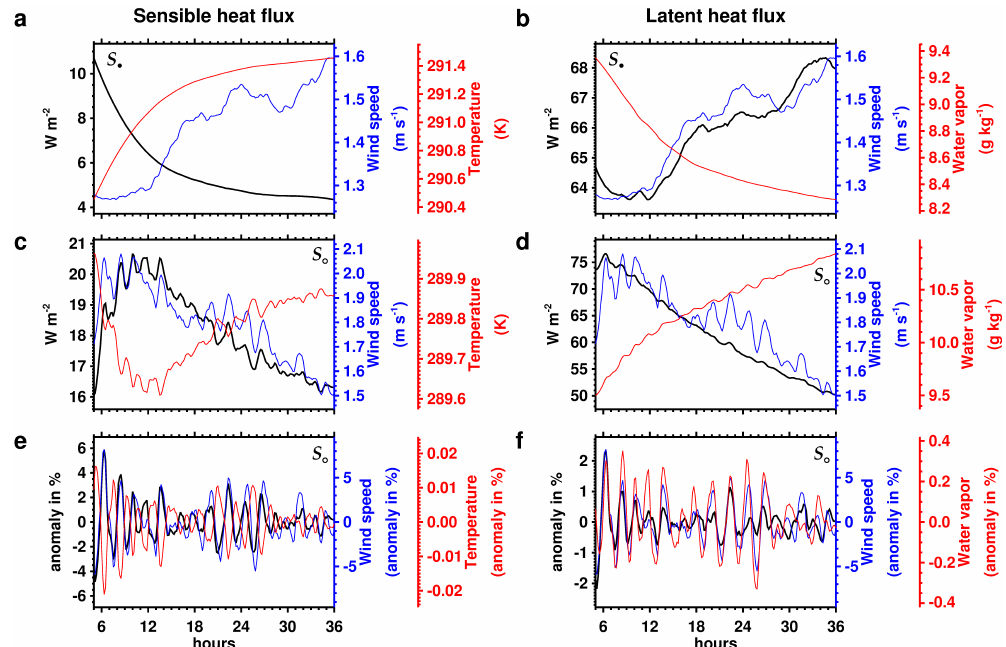
Fig. 4. Domain-averaged surface sensible and latent heat fluxes for the simulation S • (a, b) and S ◦ (c, d) , plotted with their determinant quantities (domain-averaged surface total horizontal wind speed, surface air temperature, and surface water vapor). Panels (e) and (f) show the temporal anomalies (against a 3h running mean) of the S ◦ data (c, d) .